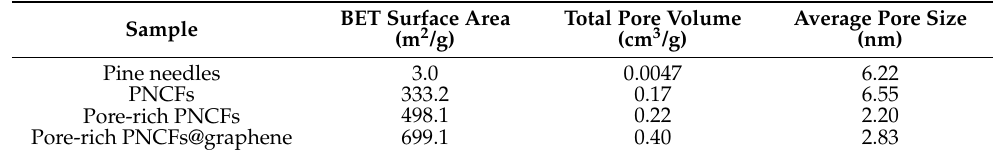
Table 1. BET surface area, calculated pore volume and average pore size of pine needles, PNCFs, pore-rich PNCFs, and pore-rich PNCFs@graphene